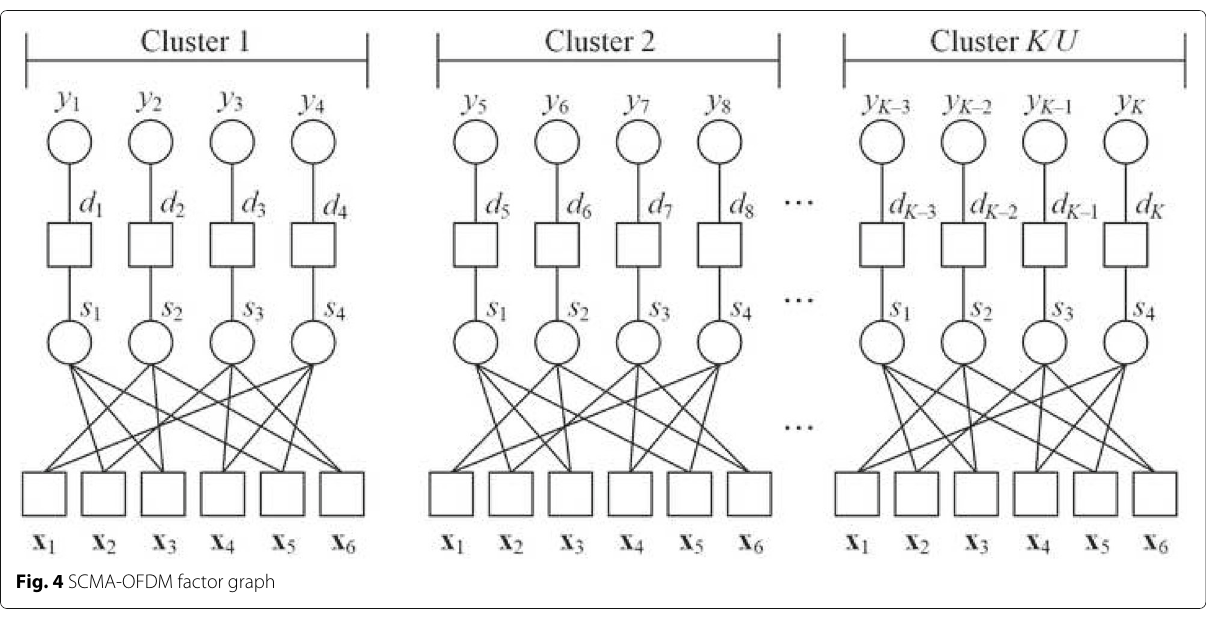
Fig. 4 SCMA-OFDM factor graph